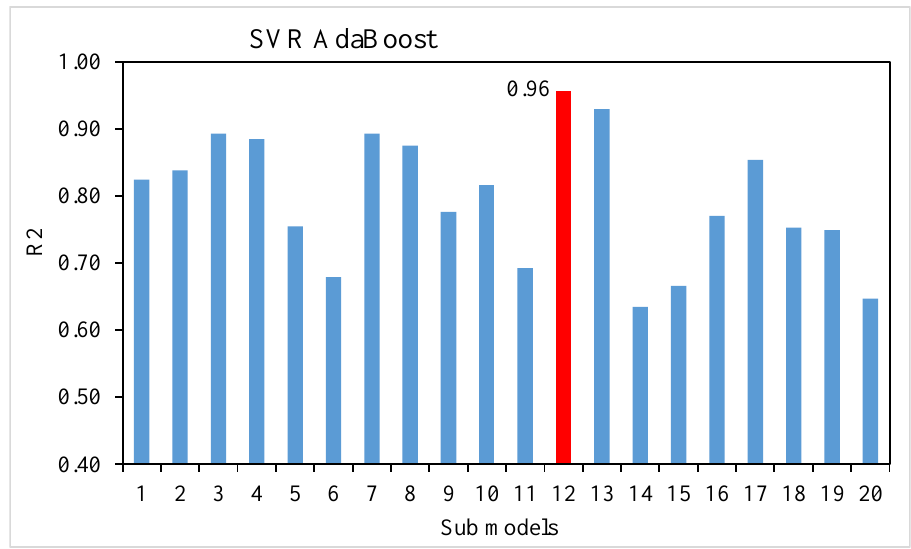
Figure 13. The coefficient of correlation (R 2 ) values of the SVR AdaBoost sub-model.